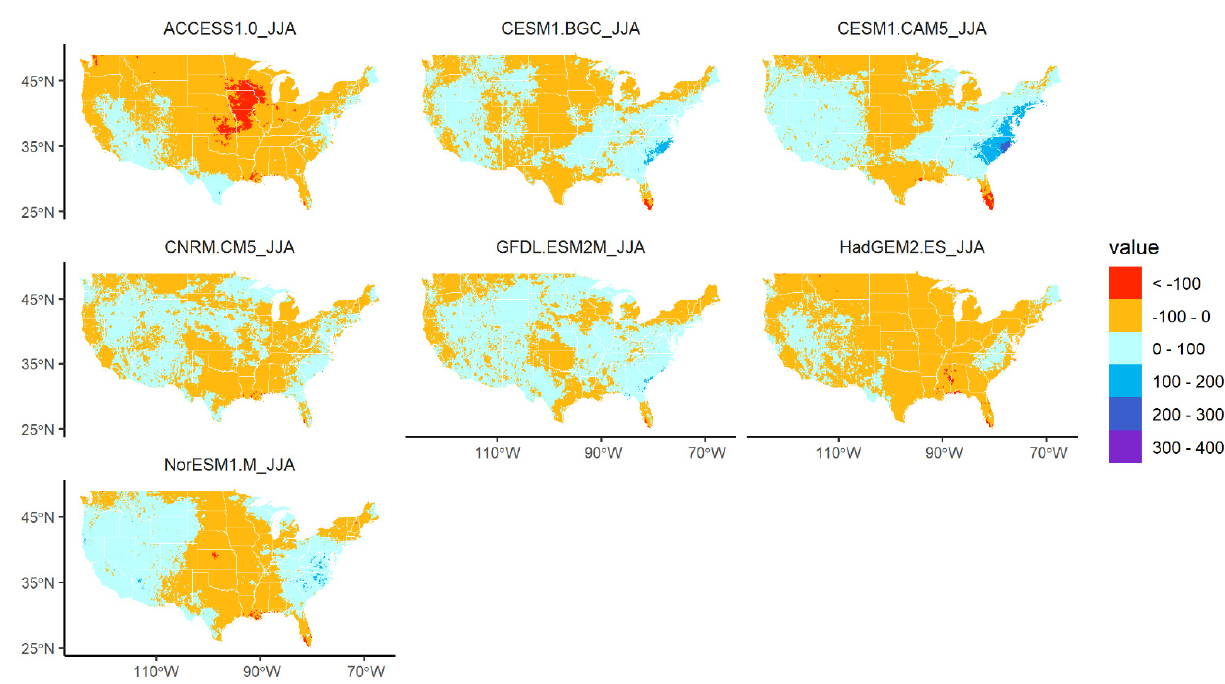
Figure A2. The projected change in summer (June through August) total precipitation (mm) for each climate projection selected for analysis under RCP 4.5 (Table A2).